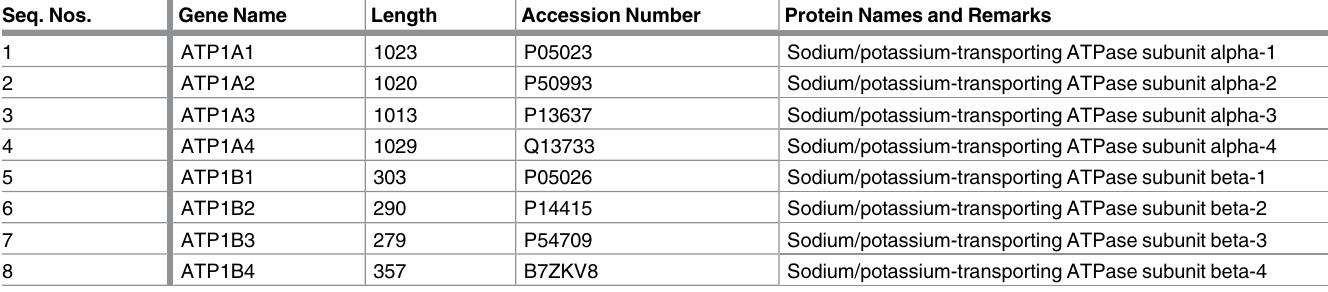
Table 8. Details of Na + /K + -ATPase family membersin human. Seq. Nos.